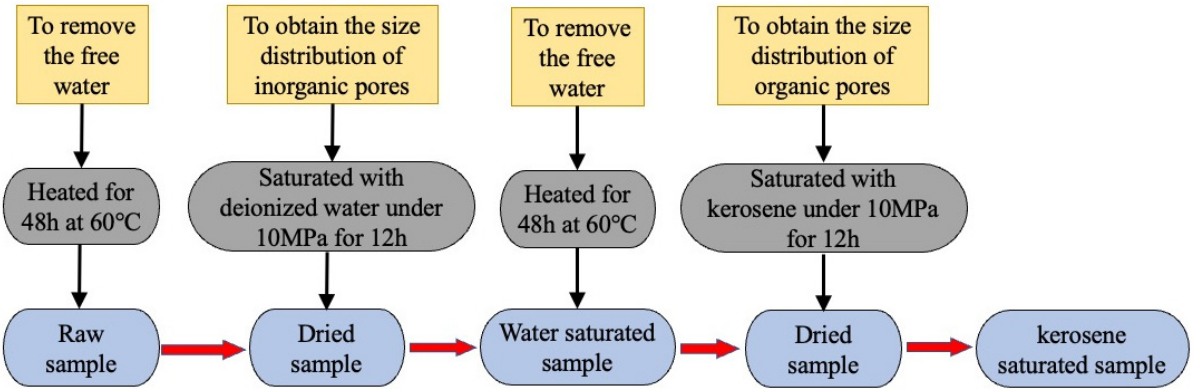
Figure 2. Detailed nuclear magnetic resonance measurement procedures and their purposes.